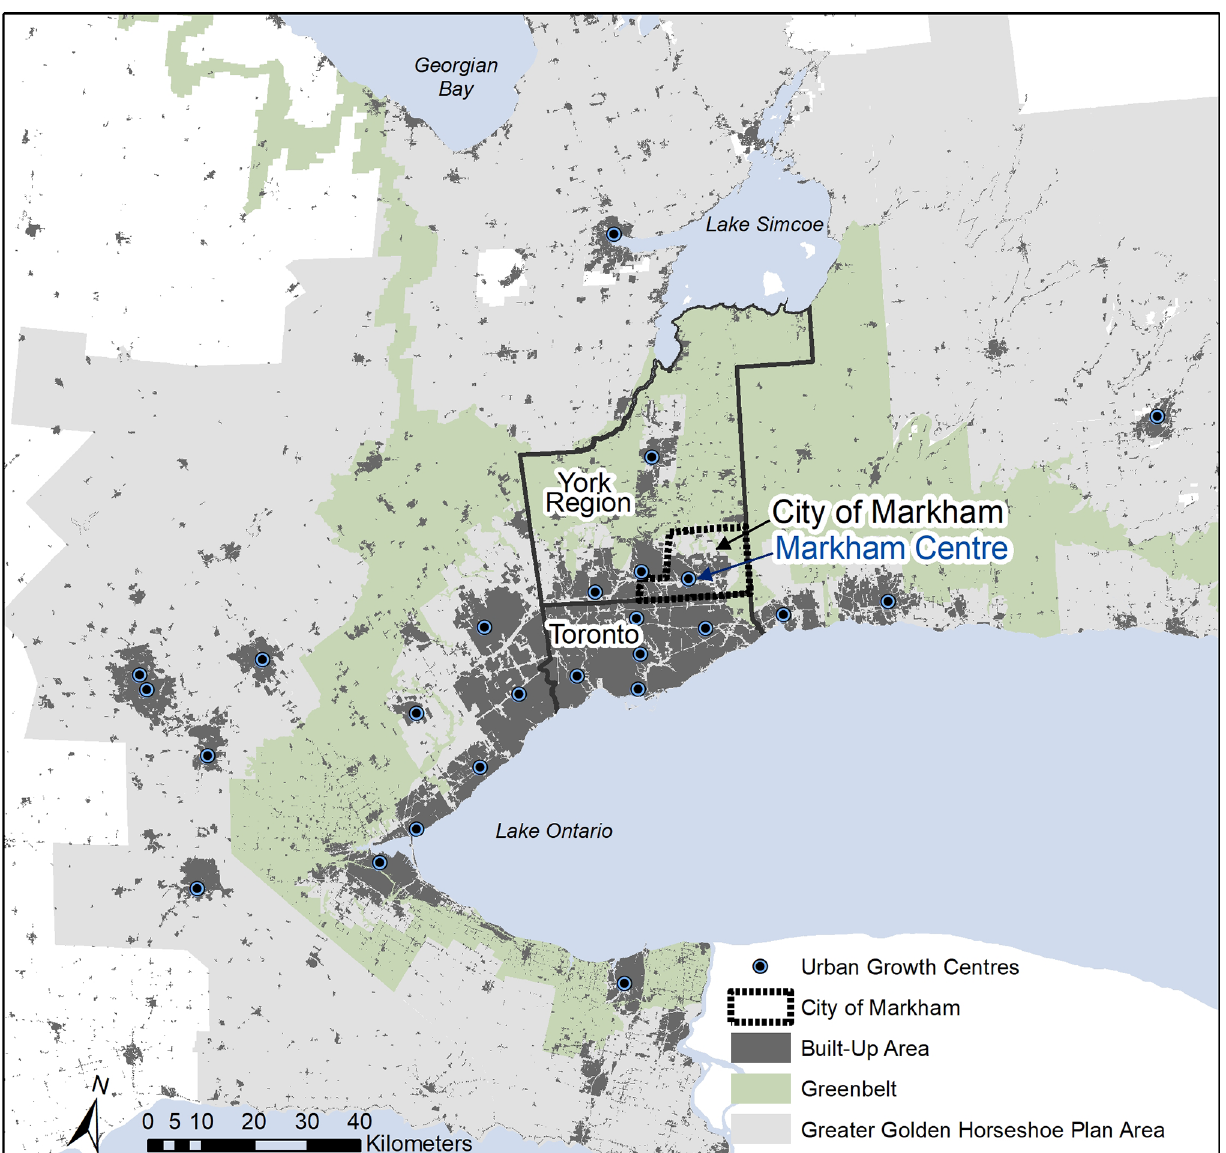
Figure 1. Markham in the context of the Greater Golden Horseshoe plan area. Markham Centre is located approximately 30 kilometres away from the City of Toronto central business district. Source: Author, based on open source data from the Province of